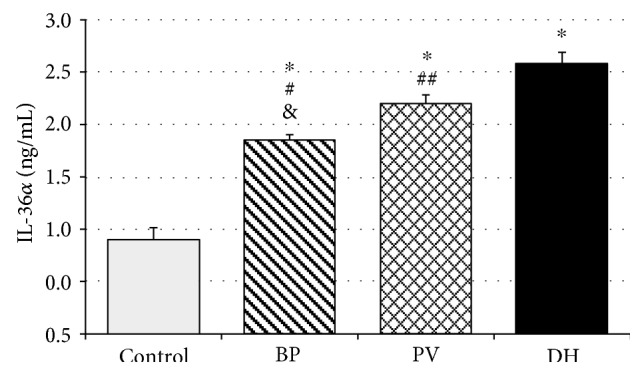
IL-36α expression in patients with bullous pemphigoid (BP), pemphigus vulgaris (PV), and dermatitis herpetiformis (DH). Data represent the mean ± SEM. ∗p < 0.0001 versus that in the control. #p < 0.0001; ##p < 0.02 versus that in DH. &p < 0.001 versus that in p.